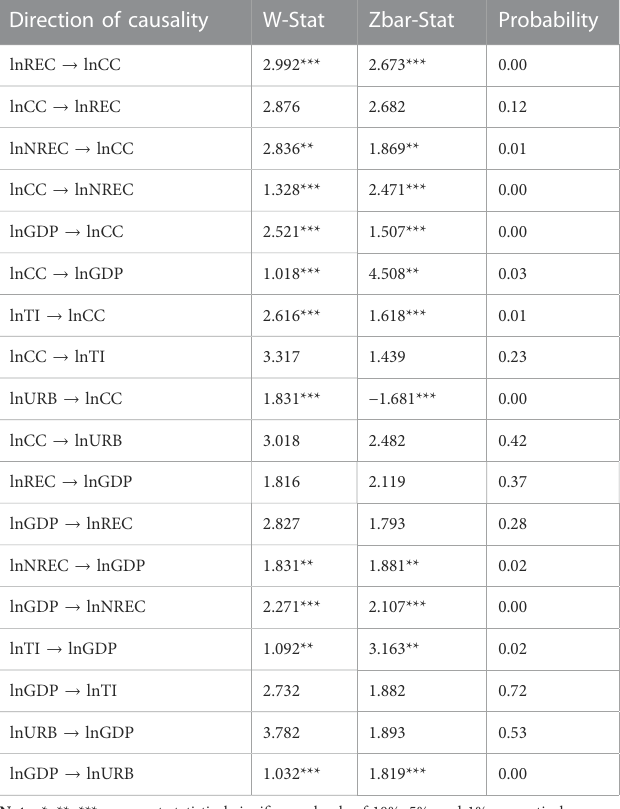
TABLE 8 Results of pairwise causal relationships between variables of interest in the proposed model using Dumitrescu and Hurlin causality test. Direction of